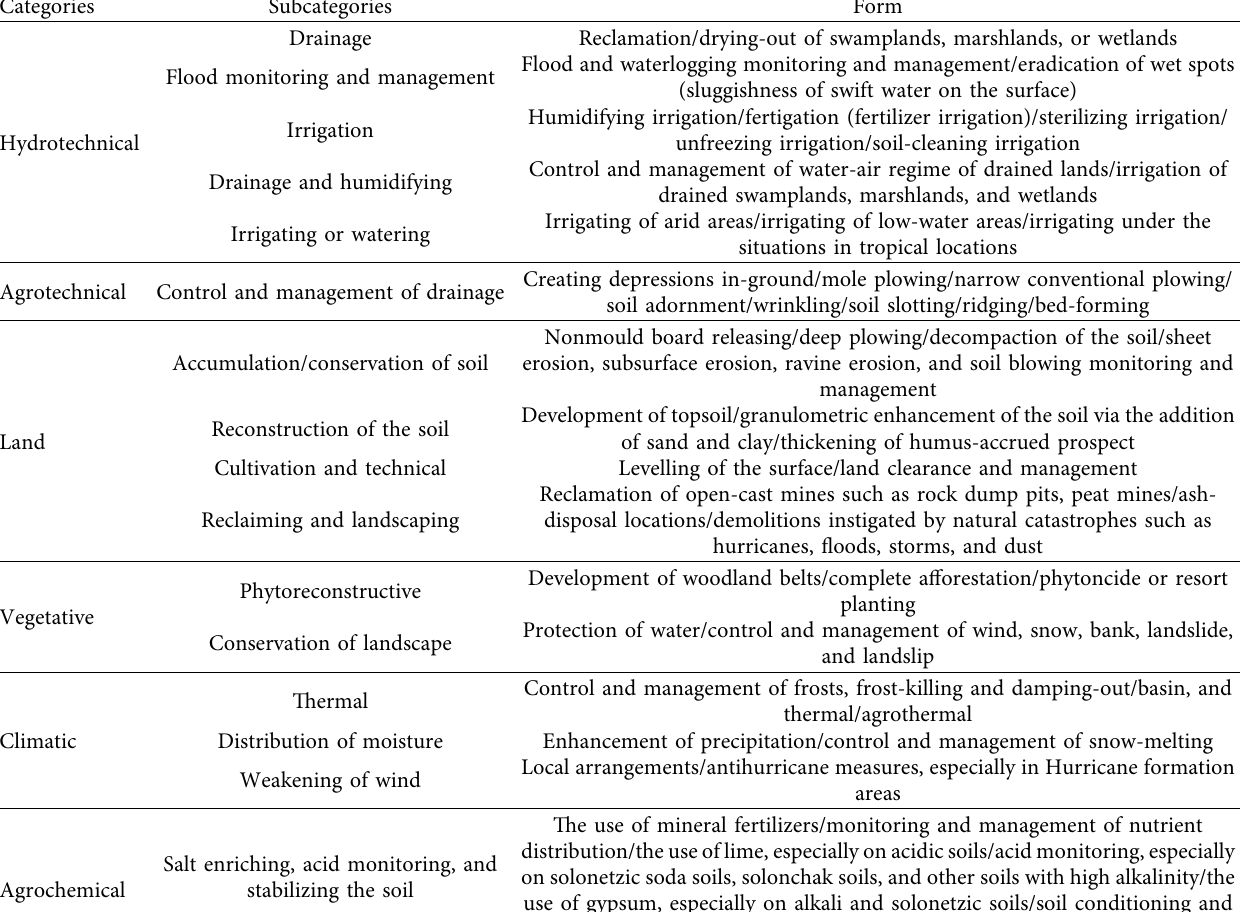
Table 2: Land reclamation